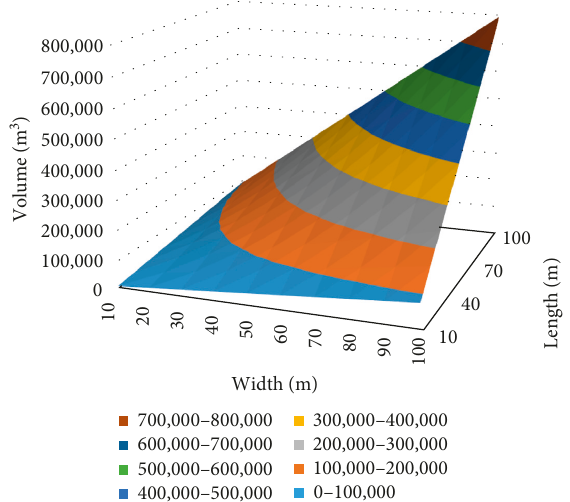
Figure 10: Changes in physical properties according to mass scale: volume (m 3